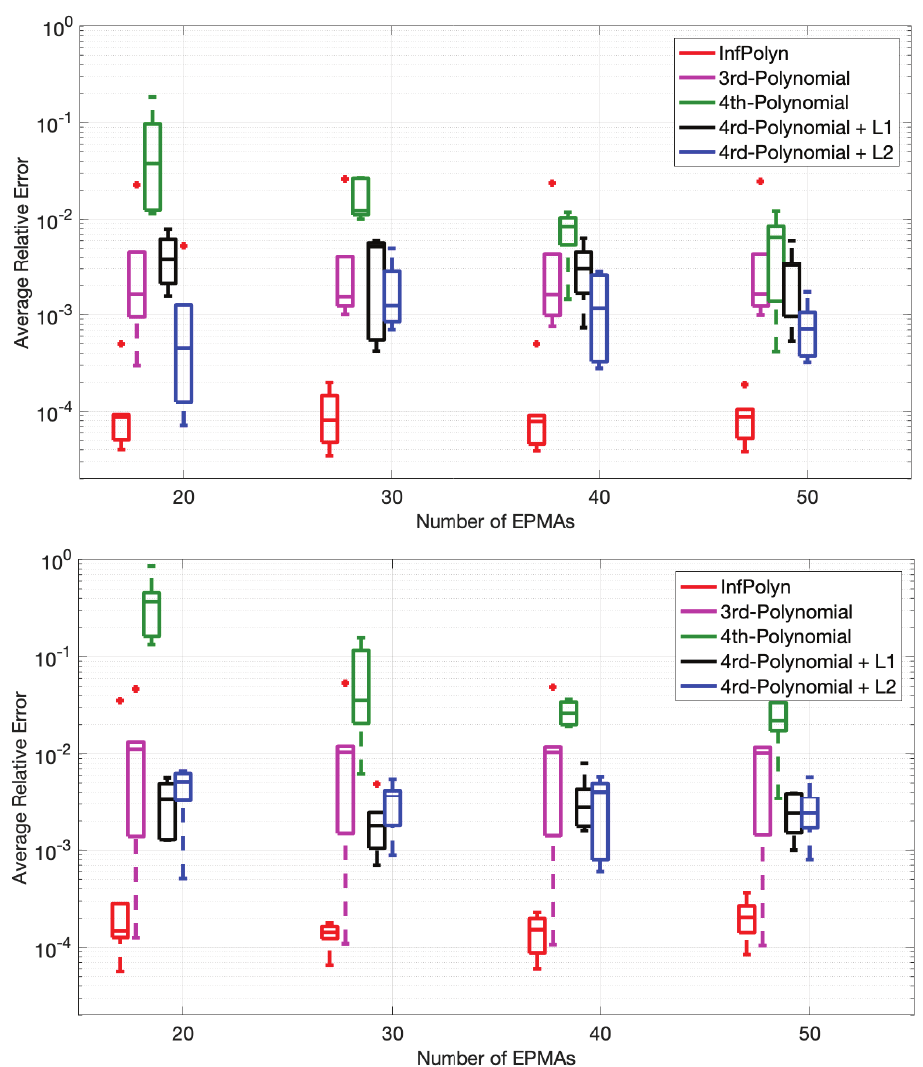
Figure 5. The Tukey box plot of average relative error of ˜ D 11 ( top ) and ˜ D 22 ( bottom ) based on computation using concentration profile consisting { 20,30,40,50 } EMPA